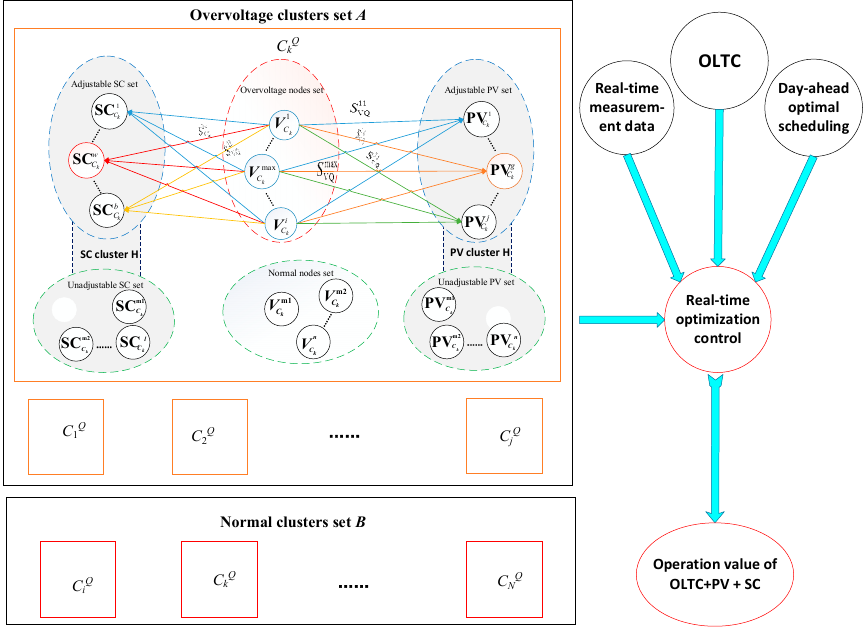
Figure 2. Network partition and process of voltage control.